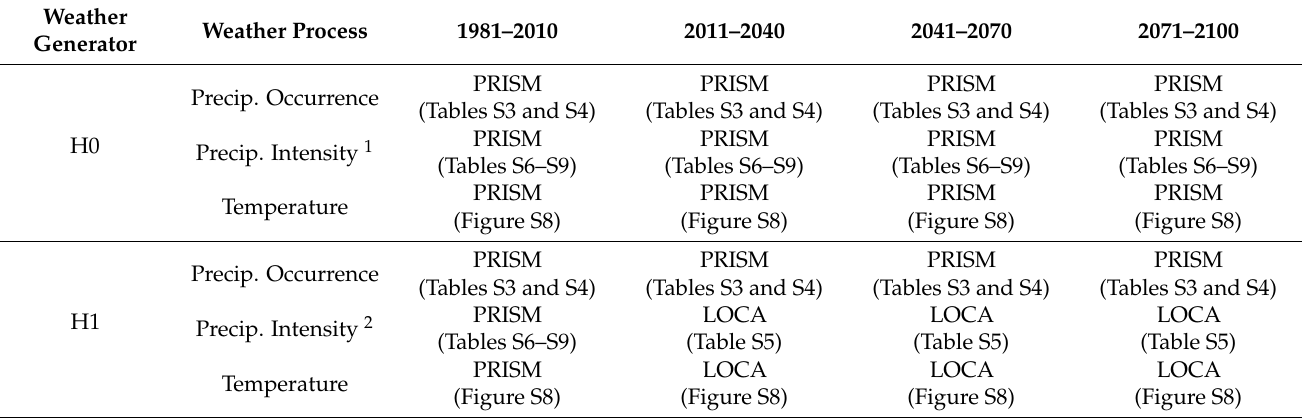
Table 3. Calibrated weather generator